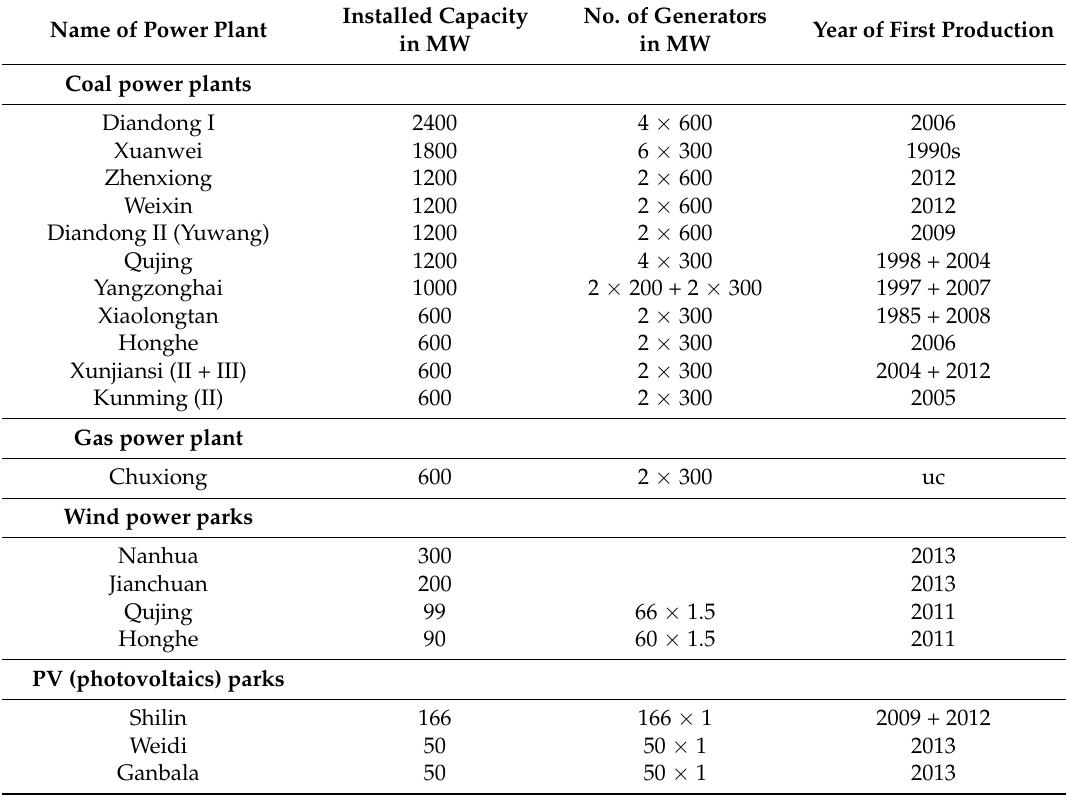
Table 2. Other large power plants of Yunnan ( ≥ 50 MW), except